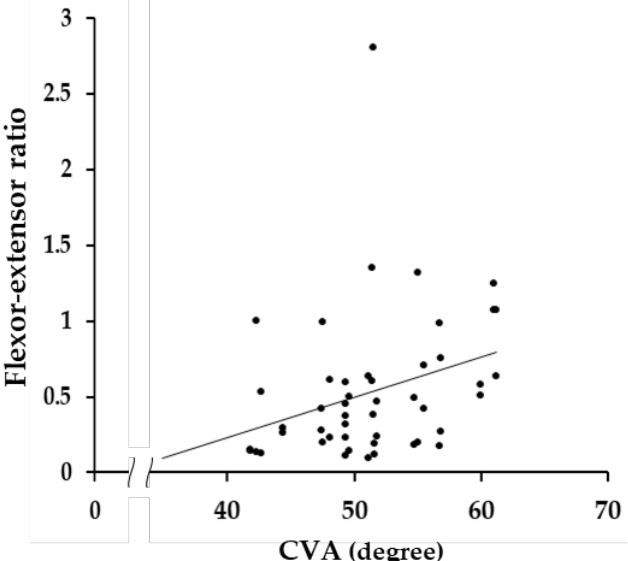
Figure 4. The correlation between craniovertebral angle (CVA) and flexor–extensor ratio of Phase II in the neutral position in the NSNP (nonspecific neck pain) group. A larger flexor–extensor ratio indicates a relatively lower extensor activity. There was a significant positive correlation ( ρ = 0.393, p = 0.006).